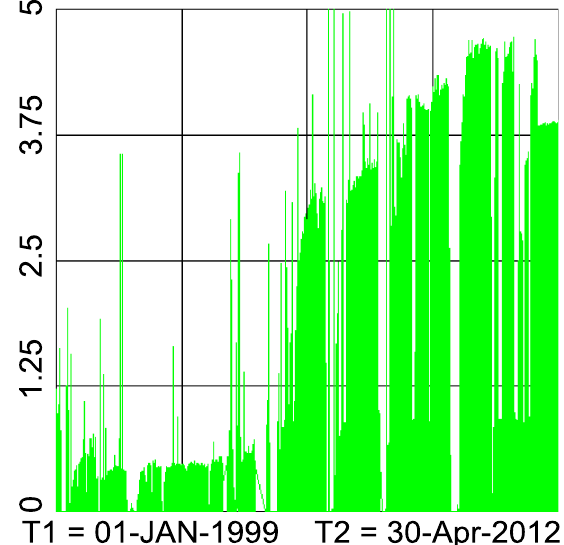
FIG. 1. Sampled intensity per cycle from January 1999 through April 2012 with full scale of 5 (cid:1) 10 13 protons per pulse (50 Tp per pulse). Vertical grid lines are at May 2, 2002, August 31, 2005, and December 30,